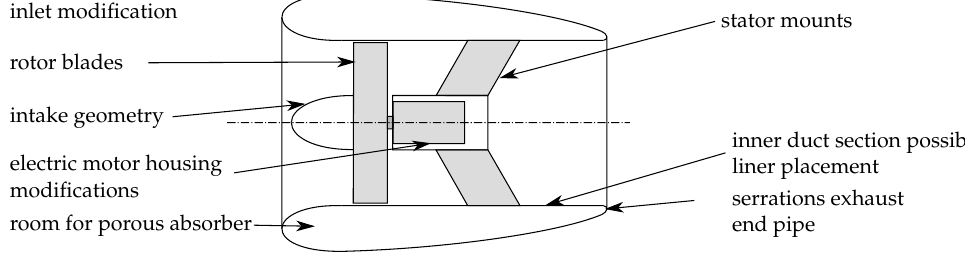
Figure 3. Visualization of potential noise reduction measures at an EDF unit. the current design, the stator is placed downstream, as so-called outlet guide vanes, to 154 significantly lower sound pressure levels (SPL) for the resulting rotor-stator interaction 155 compared to upstream stator installations [47]. The guide vanes are swept to decrease the 156 noise emissions further. No special care was taken in the current configuration by selecting 157 the rotor blade number and the guide vane number to cut off lower harmonic duct modes. 158 Also, no modifications of the leading and trailing edge serrations [48] or forward and 159 backward skew [49] were applied to the fan blades.